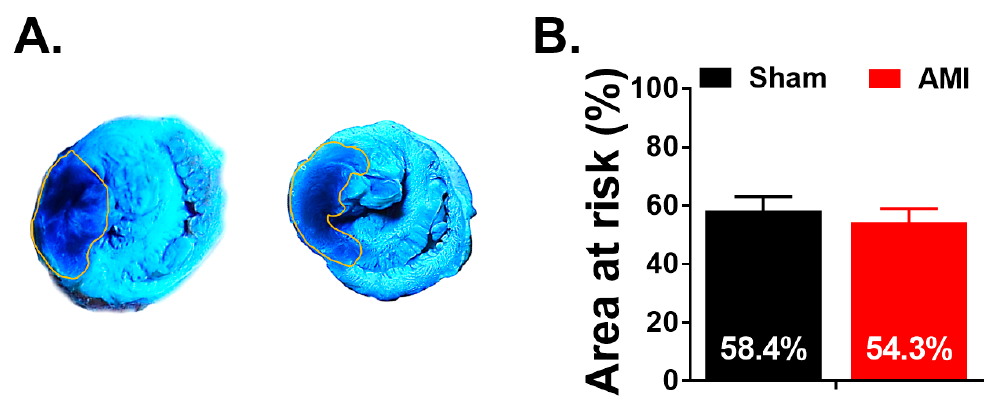
Figure 11. Area at risk. ( A ) shows representative pictures of stained tissue in sham (left) and AMI ( B ) groups. Quantification of the area at risk is depicted in panel B. Sham n = 7, AMI n = 9. Error bars: SEM.